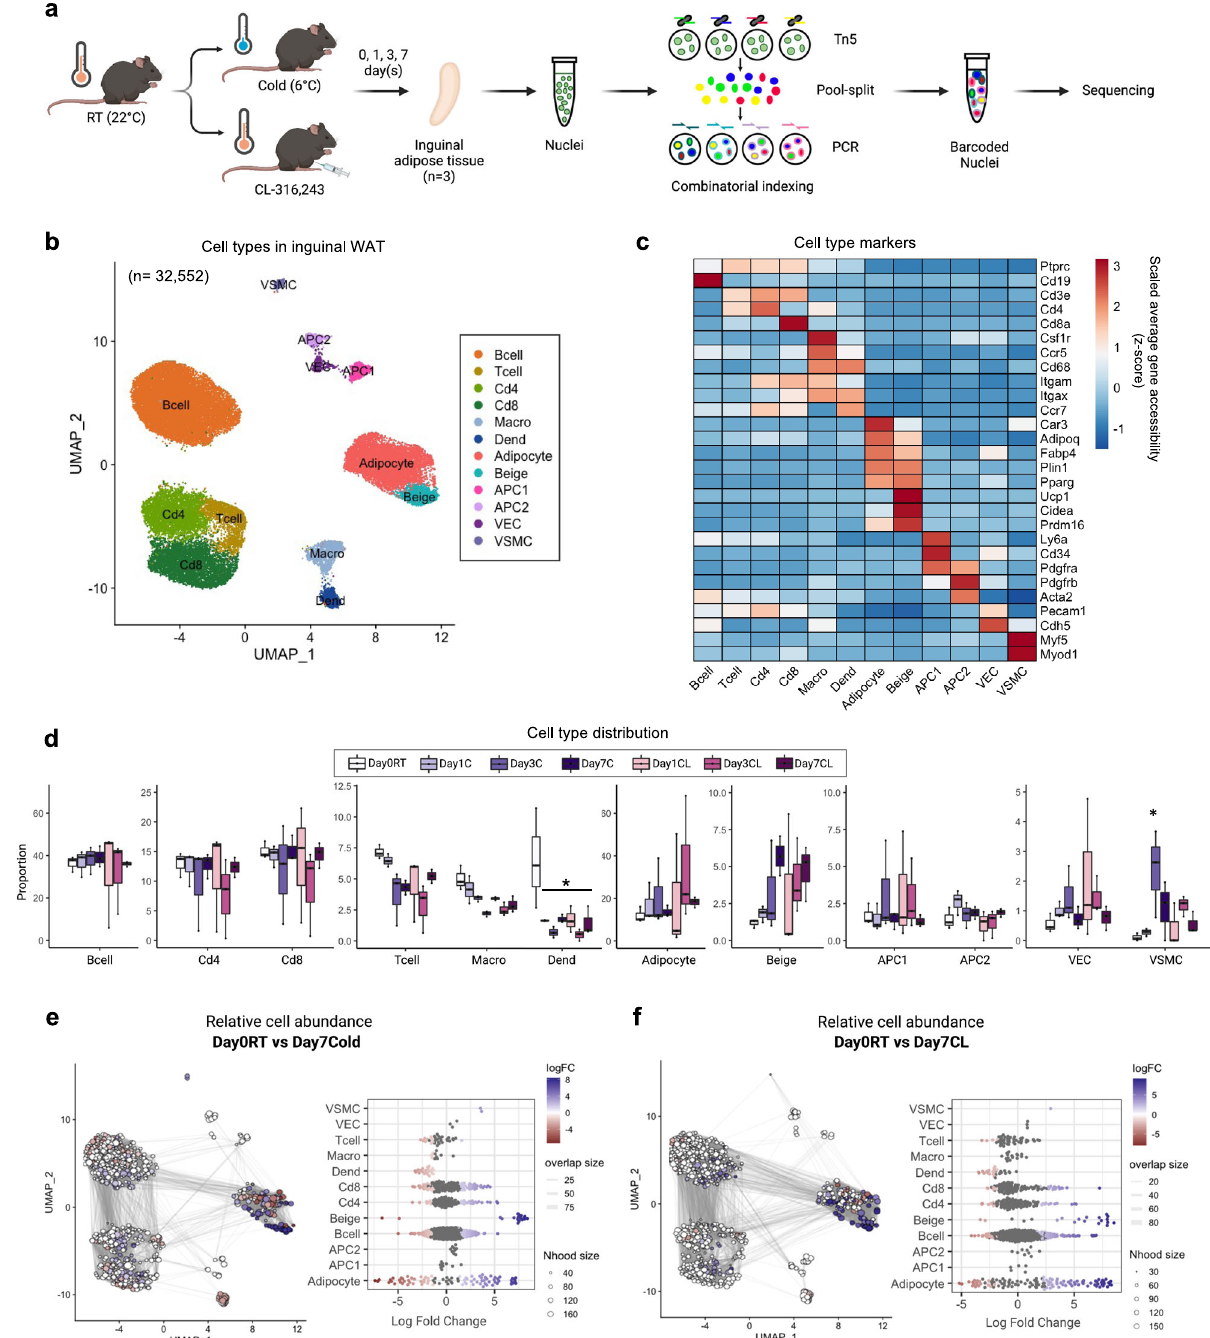
Fig. 1 Cell type identi fi cation in inguinal white adipose tissue. a Schematic outline of the work fl ow. Two-month-old male C57BL/6 mice were exposed to cold (6 °C) or CL-316,243 (CL; 1 mg/kg/mouse/day) for 1, 3, or 7 days ( n = 3 per group). Cartoons of mice and thermometers created with BioRender.com. Inguinal adipose tissues collected at day 0, 1, 3, and 7 after exposure was subjected to snATAC-seq. b UMAP plot of 32,552 cells that passed quality control. Colors represent 12 different clusters determined by unbiased clustering. c Heatmap of normalized accessibility of cell-type marker genes. d Relative proportions of each cell type per group ( n = 3 per group). *Adjusted p -value<0.05, ANOVA multiple comparisons test with Bonferroni ’ s post-hoc test was performed. e , f Milo analysis of cell neighborhood abundance changes in Day 0 RT vs . Day 7 cold e , or Day 7 CL f on UMAP plots. Size of points indicates the number of cells in a neighborhood; lines represent the number of cells shared between adjacent neighborhoods. Points are neighborhoods (Nhood), colored by the log fold differences at the two time points (FDR 10%). Beeswarm plots show the distribution of the log-fold in de fi ned clusters. Macro Macrophage, Dend Dendritic cell, APC1 Adipocyte progenitor cell 1, APC2 Adipocyte progenitor cell 2, VEC Vascular endothelial cell, VSMC Vascular smooth muscle cell.